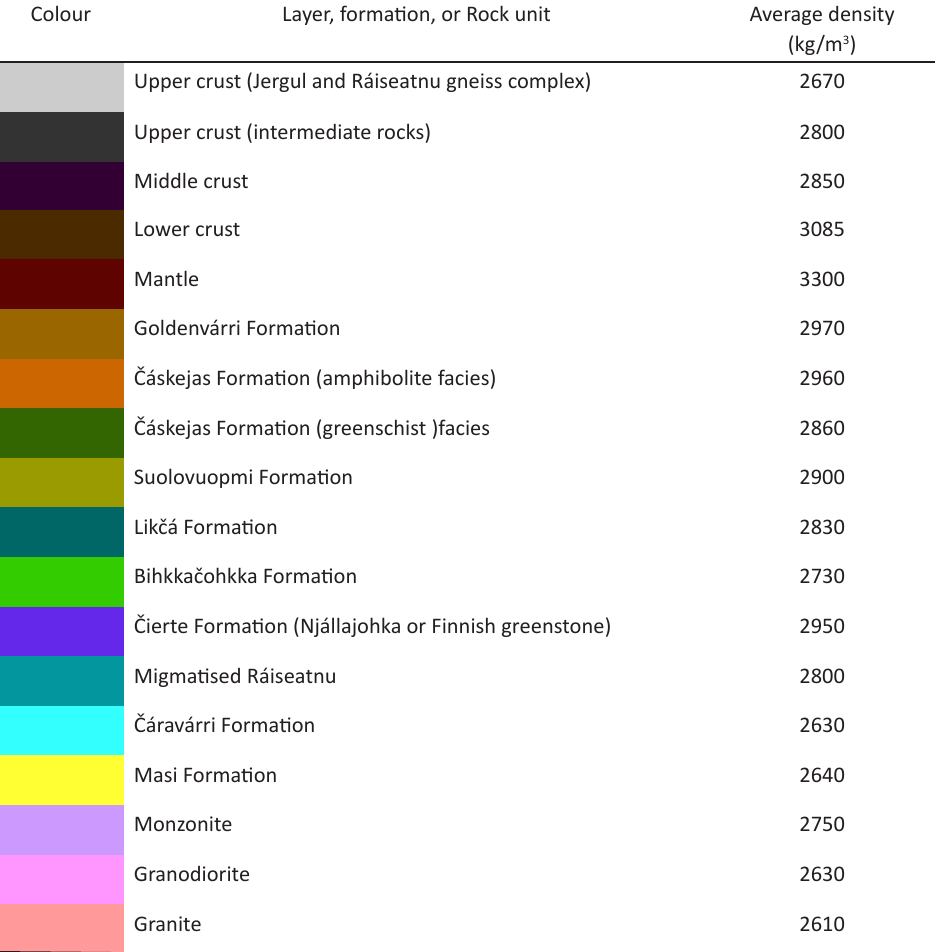
Table 1. Densities, assigned to crustal blocks/layers and mantle for the 3D model. Colours are the same as used for visualisation of the IGMAS model in Figs.